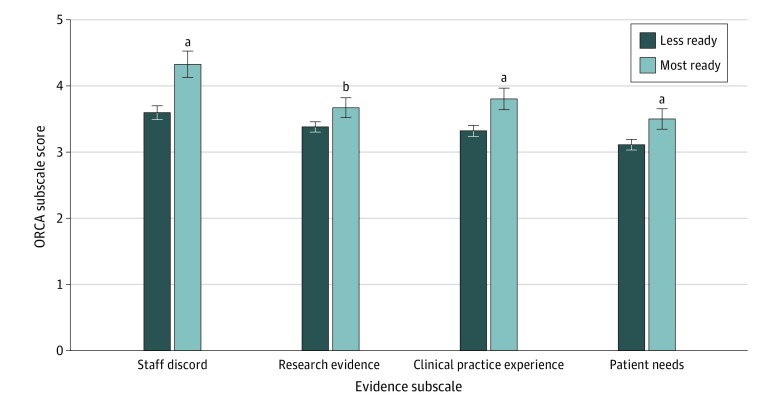
Organizational Readiness to Change Assessment (ORCA) Evidence Subscales by Readiness to Initiate Buprenorphine Treatment in the Emergency DepartmentData are expressed as mean scores; error bars indicate 95% CI.aP < .001bP = .001